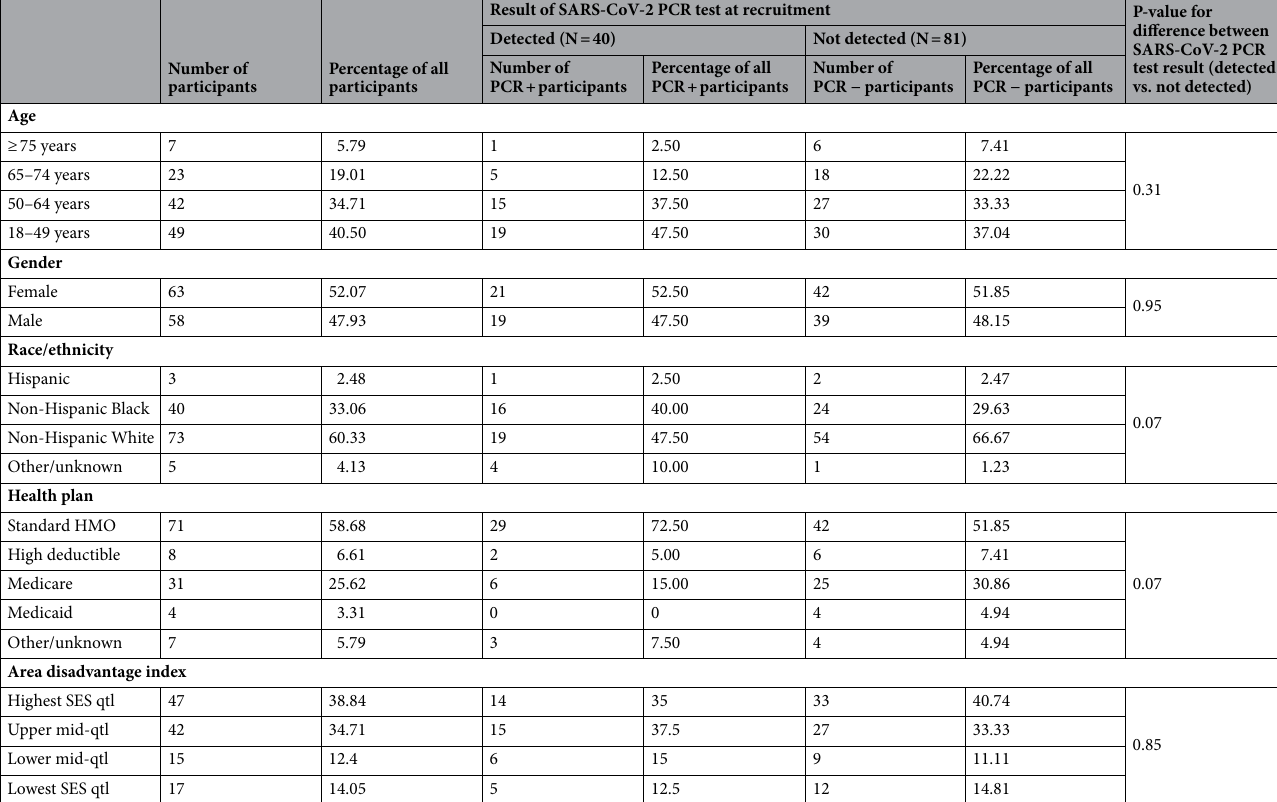
Table 1. Demographics of study participants. p-values were computed using the chi-square test. Fisher’s exact tests were also run in consideration of small cell sizes. In all cases, the p-values for the chi-square or Fisher’s tests were > 0.05.